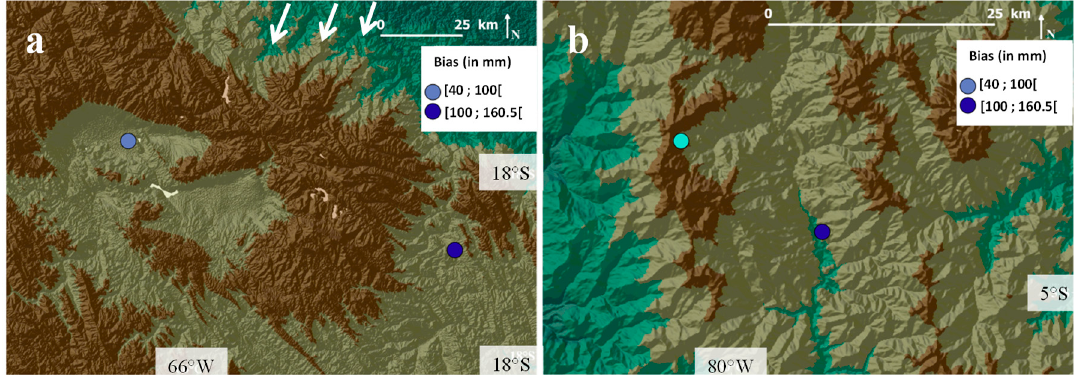
Figure 9. Correlation between elevation and ( a ) bias, in %; ( b ) relative RMSE, in mm; ( c ) POD; and ( d ) FAR in the region west. The x -axis represents the elevation (in meters), y -axis represents the score of each statistic.